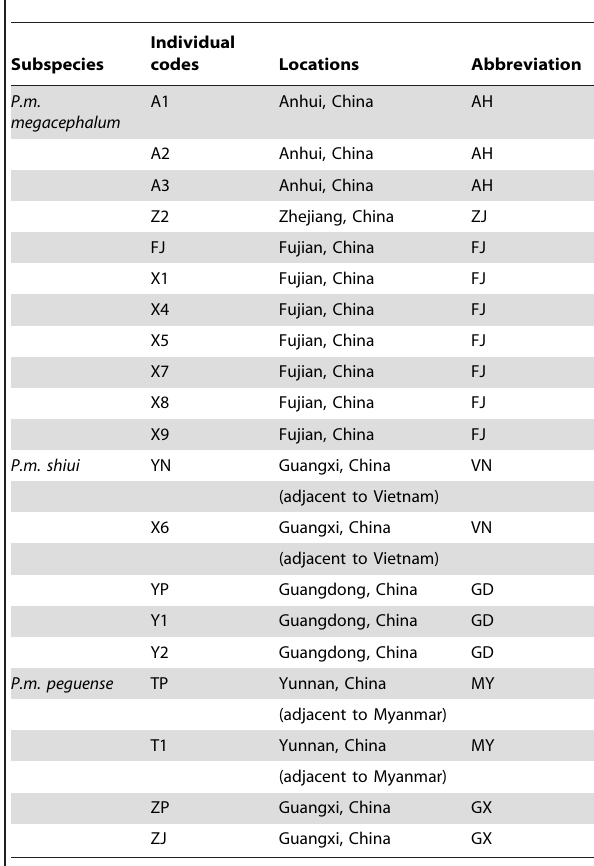
Table 1. Locations of sample